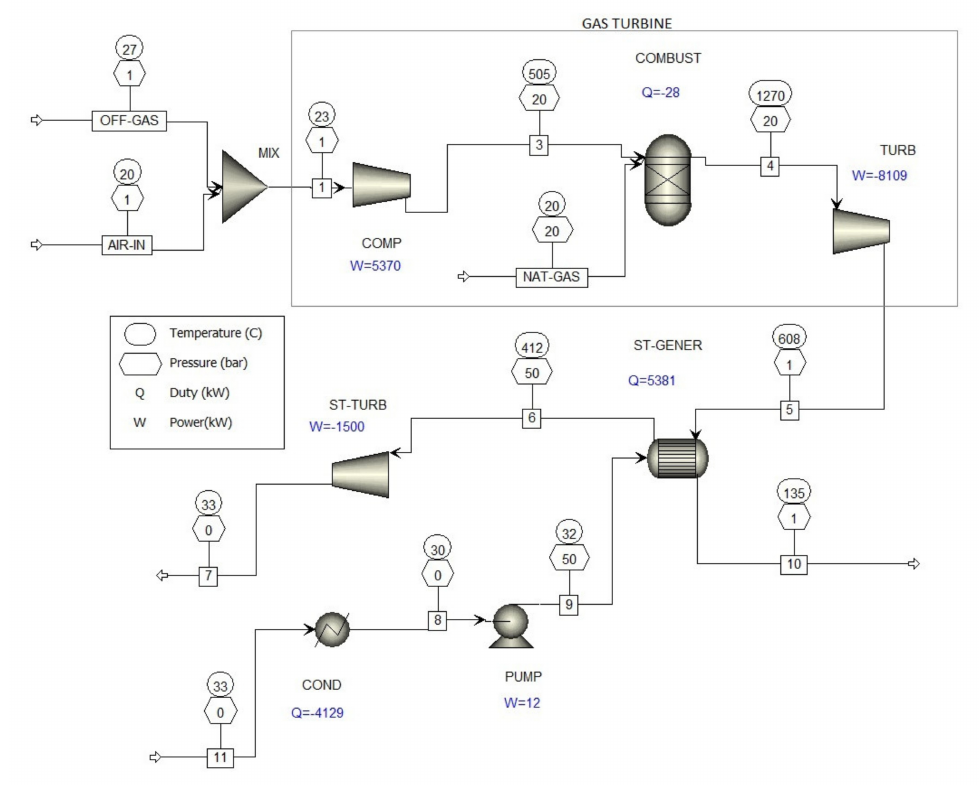
Figure 5. Computer simulation of the co-incineration of waste industrial gases from metal oxide catalyst formaldehyde production processes in a combined-cycle gas turbine